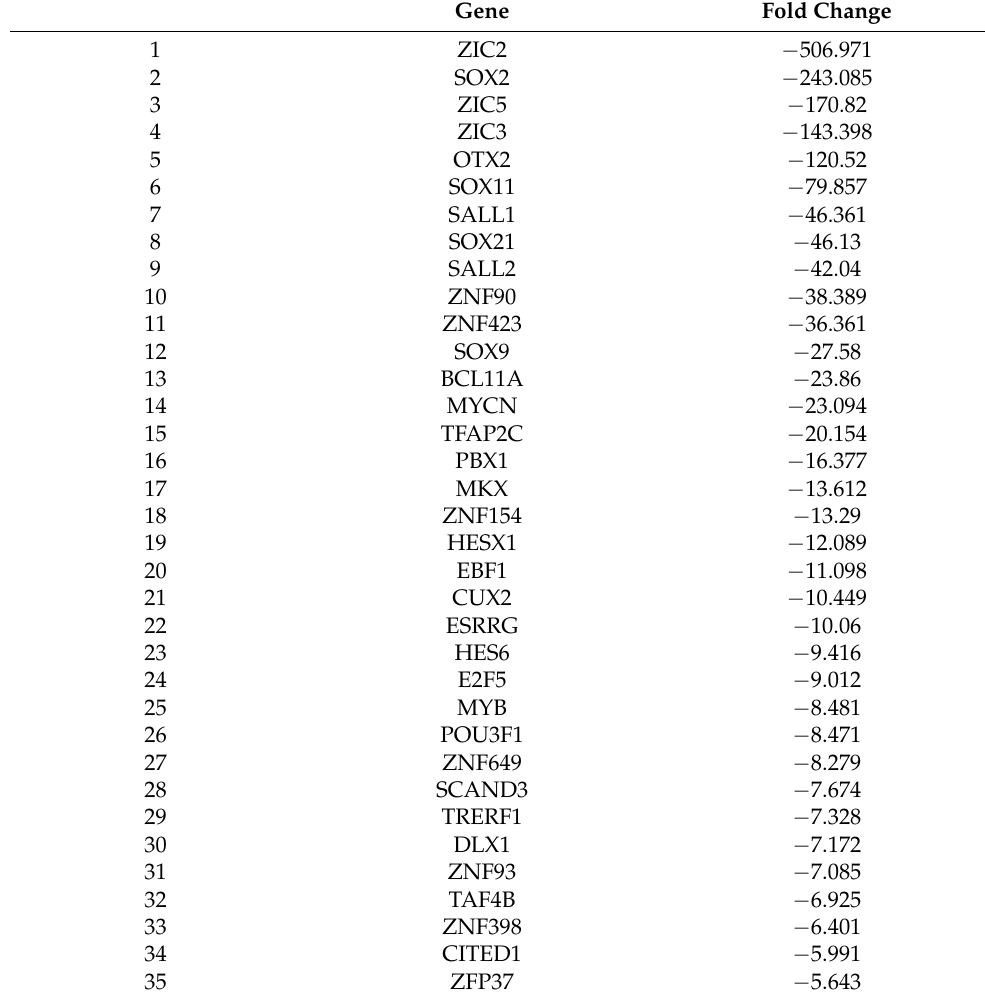
Table 4. Genes in transcription factor category that are downregulated in endothelial